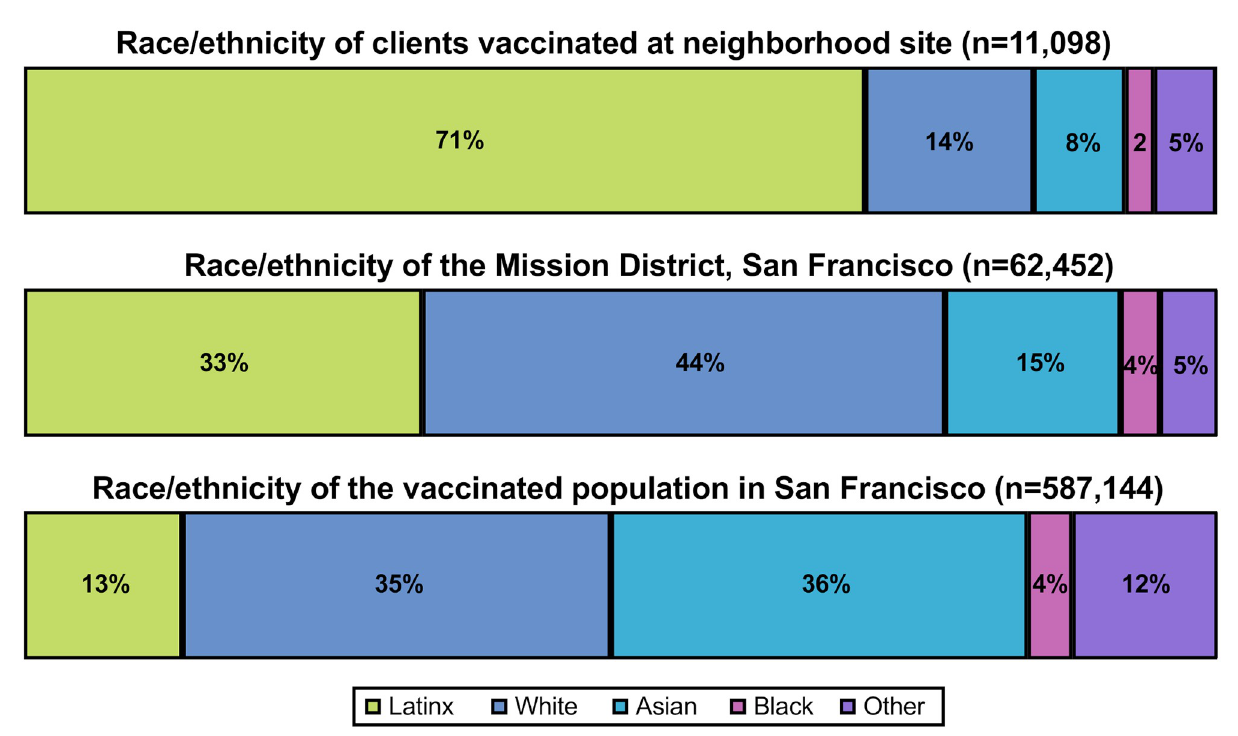
Fig 3. Race/ethnicity of clients vaccinated at the Unidos en Salud neighborhood site (n = 11,098) compared to the race/ethnicity of Mission District (n = 62,452) residents 16 years of age and older as well as the race/ethnicity of all vaccinated individuals 16 years of age and older in San Francisco, California (n =